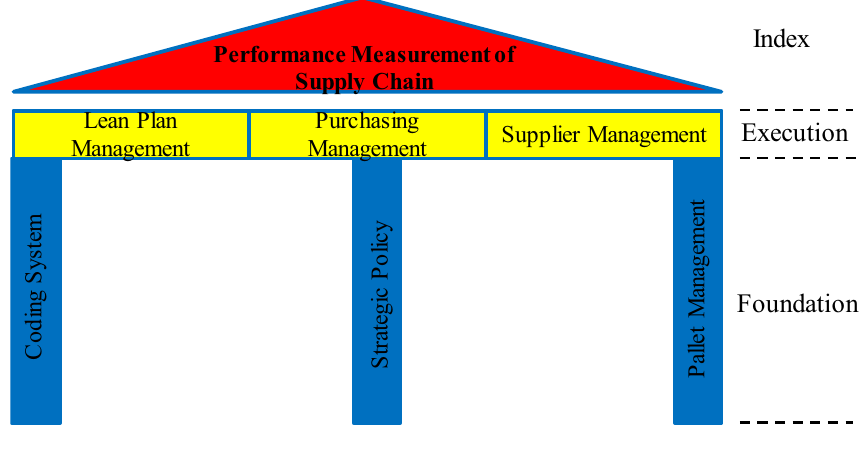
Fig.5 Frame of LSCM for ship-